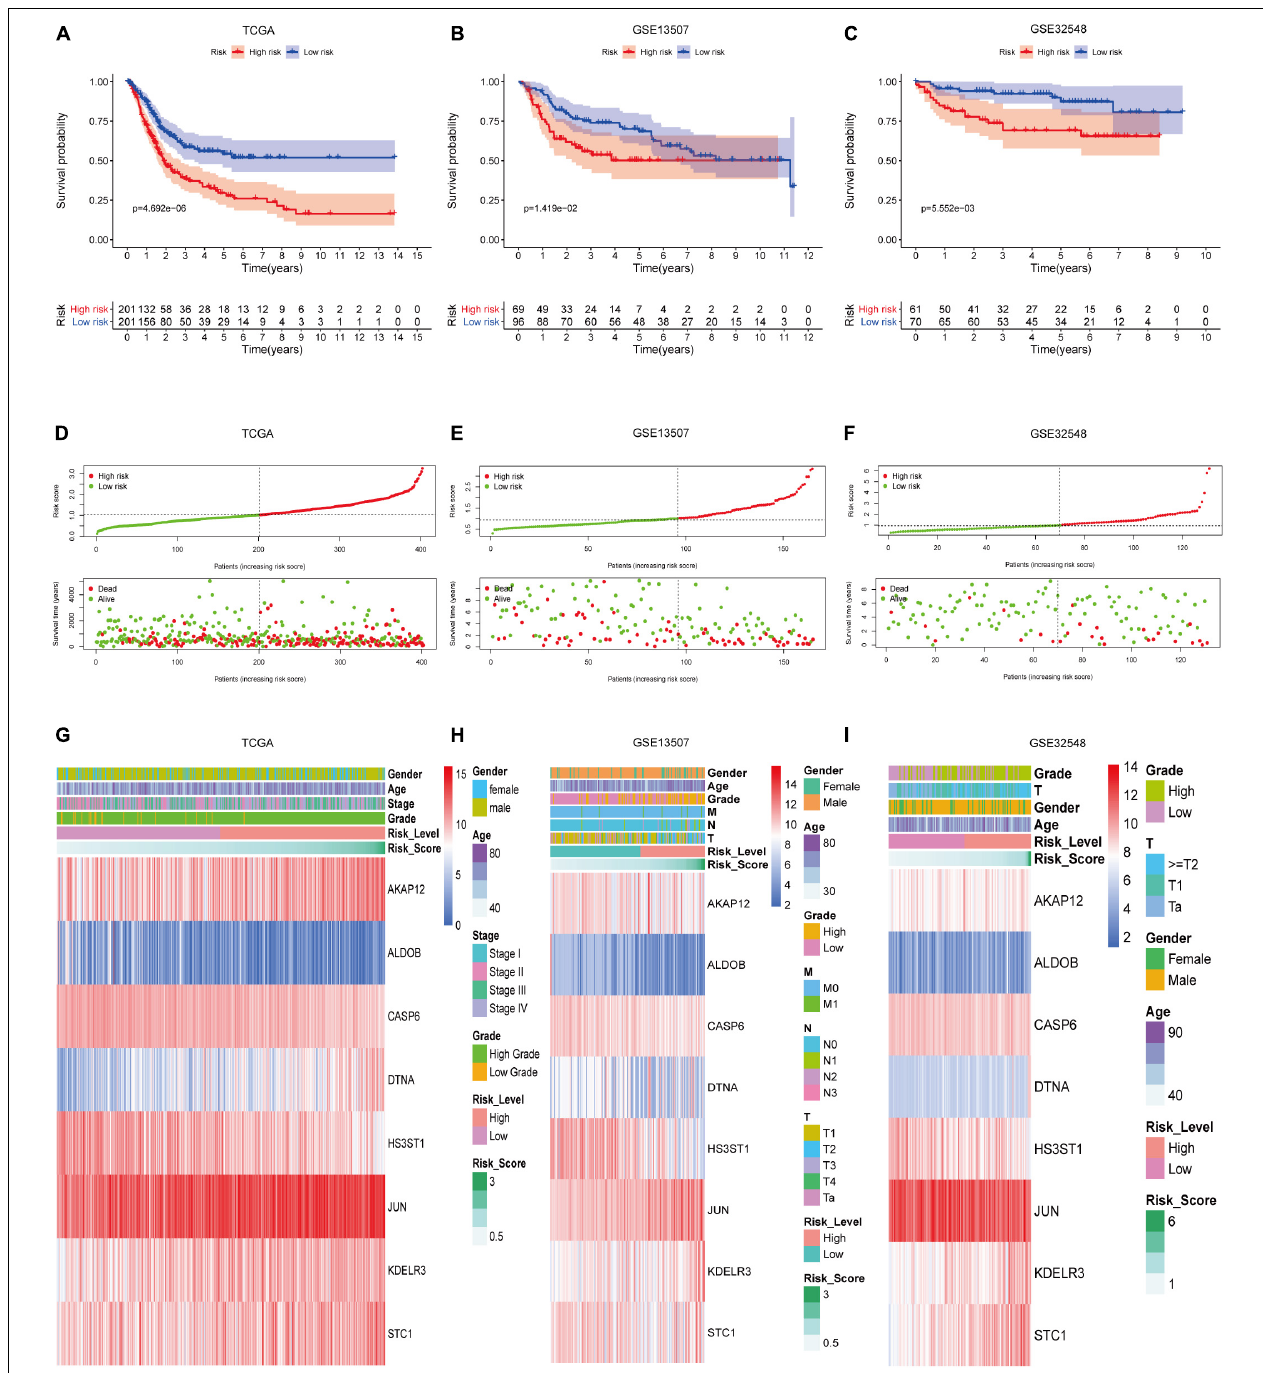
FIGURE 4 | The performance of hypoxia signature in three datasets. Kaplan–Meier analysis showed that patients with lower risk scores had better overall survival than the ones with higher risk scores in the training set (A) , GSE13507 (B) , and GSE325489 (C) . The risk scores of patients were ranked sequentially, and patients with lower risk scores usually had longer survival time and lower mortality rates compared with those with higher risk scores in the training set (D) , GSE13507 (E) , and GSE325489 (F) . Multigroup heat maps of the hypoxia signature in the training set (G) , GSE13507 (H) , and GSE325489 (I) .